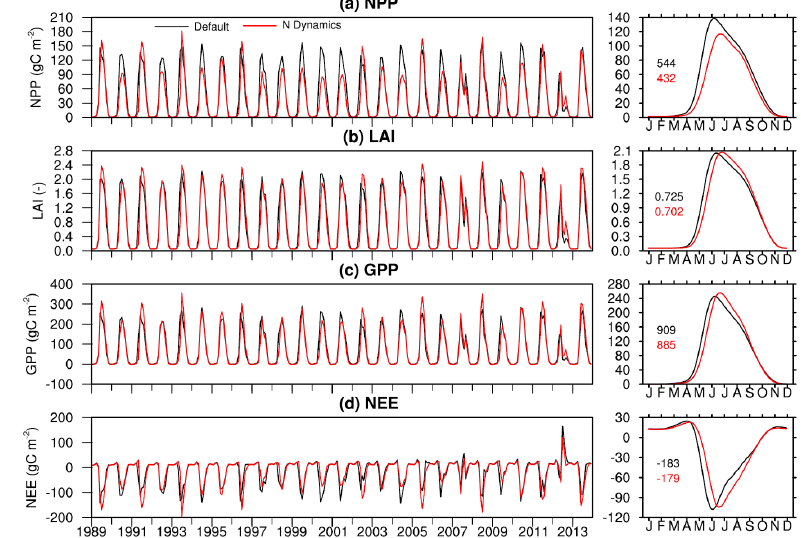
Figure 6. (left column) Monthly and (right column) climatologically seasonal cycle of model-simulated (a) LAI, (b) NPP, (c) GPP, and (d) NEE from default Noah-MP and enhanced Noah-MP with N dynamics. The values in the right column indicate annual mean for each term (black: Noah-MP without N dynamics; red: Noah-MP with N dynamics).